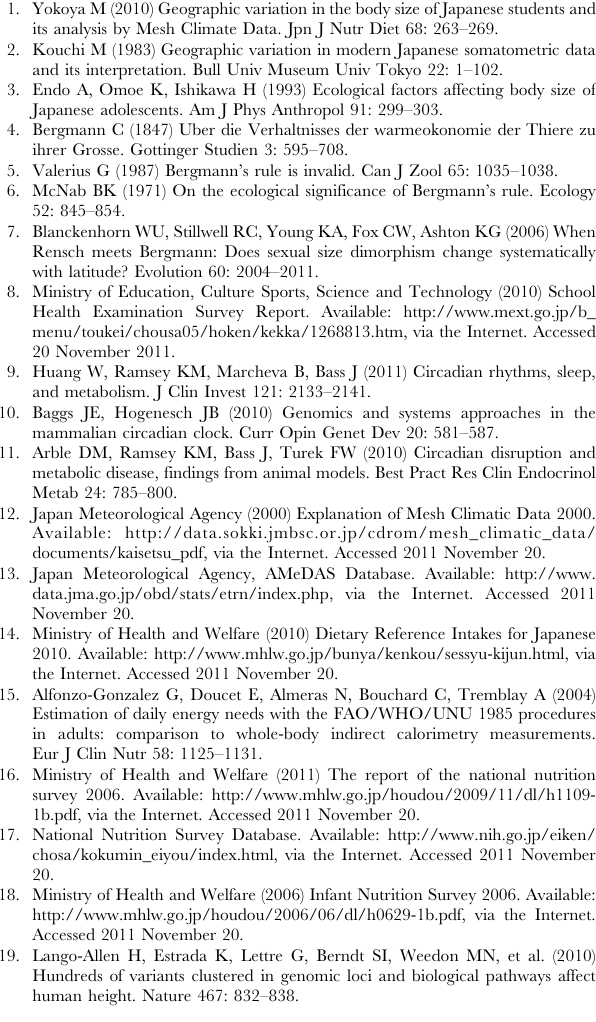
Table S1 Standardized height of 8- to 17-year-old Japanese youth in each prefecture averaged over a 13- year period (1996 to 2008). Table S2 Standardized weight of 8- to 17-year-old Japanese youth in each prefecture averaged over a 13-